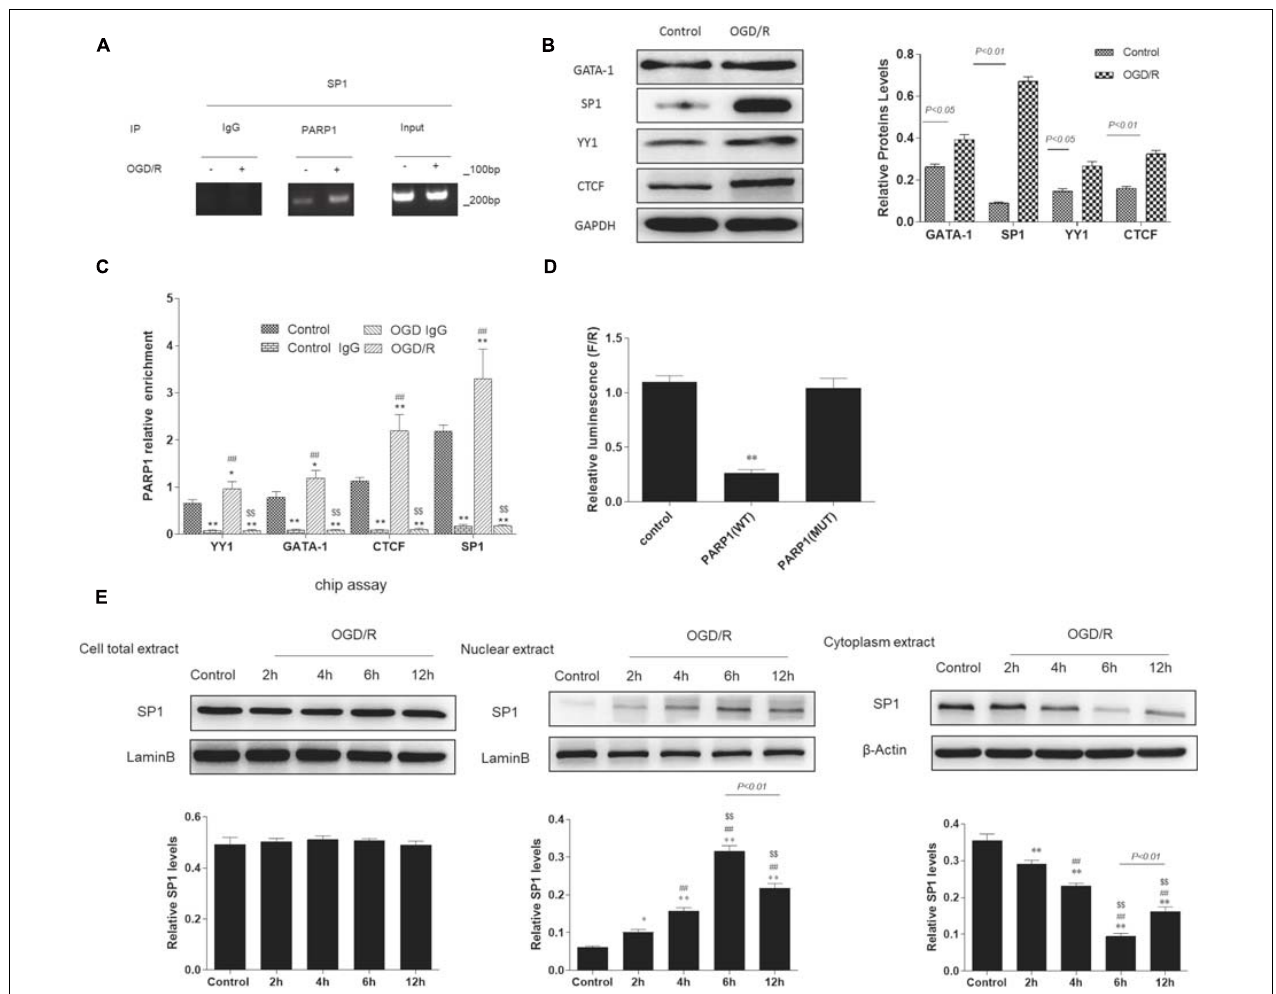
FIGURE 3 | Sp1 is a transcription factor of PARP1 that regulates the target gene of PARP1 during transcription. (A) In ChIP assays, the DNA fragment size of target protein antibody PARP1 and input group IP were 100-200 bp. IgG was served as a negative control and input was a positive control. (B) Western blot analysis showed the expression of different transcription factors. Compared with control group, * P < 0.05, ** P < 0.01. (C) Real-time PCR showed the mRNA expressions of PARP1 which were recruited by different transcription factors. Compared with control group, * P < 0.05, ** P < 0.01; compared with control IgG group, ## P < 0.01; compared with OGD/R group, $$ P < 0.01. (D) The fluorescein value in the dual-luciferase reporter assay decreased significantly after mutation of PARP1, indicating that there was a targeted regulation between Sp1 and PARP1. Compared with control group, ** P < 0.01. (E) Western blot was performed in nuclear extract level, cytoplasm extract level and cell total extract level to show different protein expression levels of Sp1. Compared with control group, * P < 0.05, ** P < 0.01; compared with OGD/R-2 h group, # P < 0.05, ## P < 0.01; compared with OGD/R-4 h group, $ P < 0.05, $$ P < 0.01. N = 4 for each group.